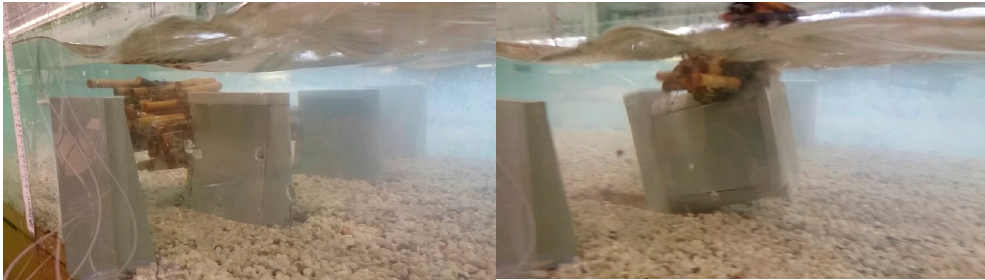
Figure 7. Self-standing pier failure without the deck.